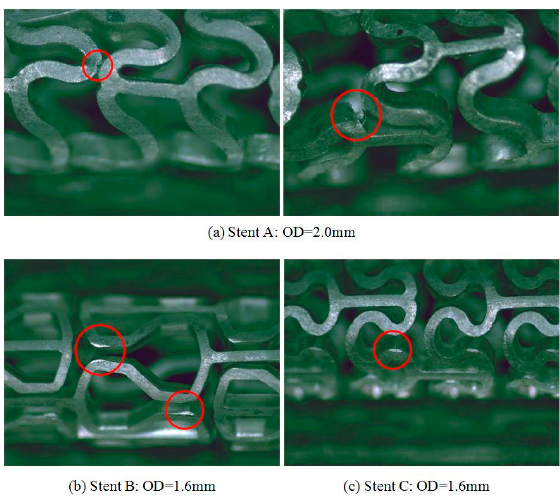
Figure 14. ( a ) Fracture and ( b , c ) squeezed planes after the crimping procedure.